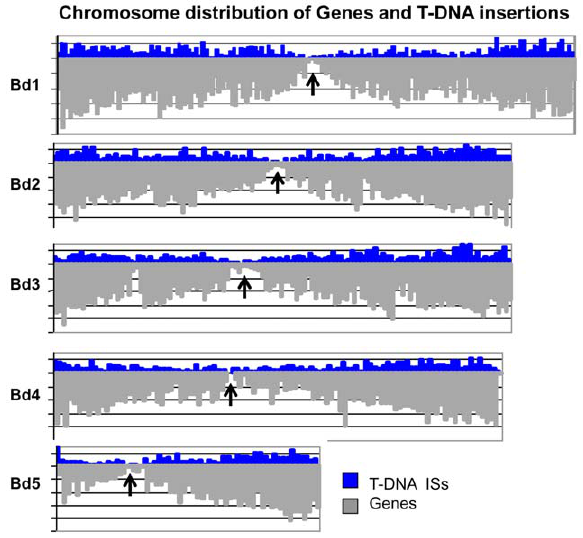
Figure 5. Distribution of Genes and T-DNA insertions along the chromosomes. T-DNA insertions (blue) and Brachypodium genes (gray) are plotted in 500 kb windows moving across the length of each chromosome. Each division on the Y-axis represents 20 insertions sites or genes, respectively. Chromosome numbers are listed to the left. Insertions span the length of all five chromosomes and are positively correlated with genic regions. A greater density of insertions is observed near the distal ends of the chromosomes than is observed near the centromeres (approximate locations indicated by black arrows).